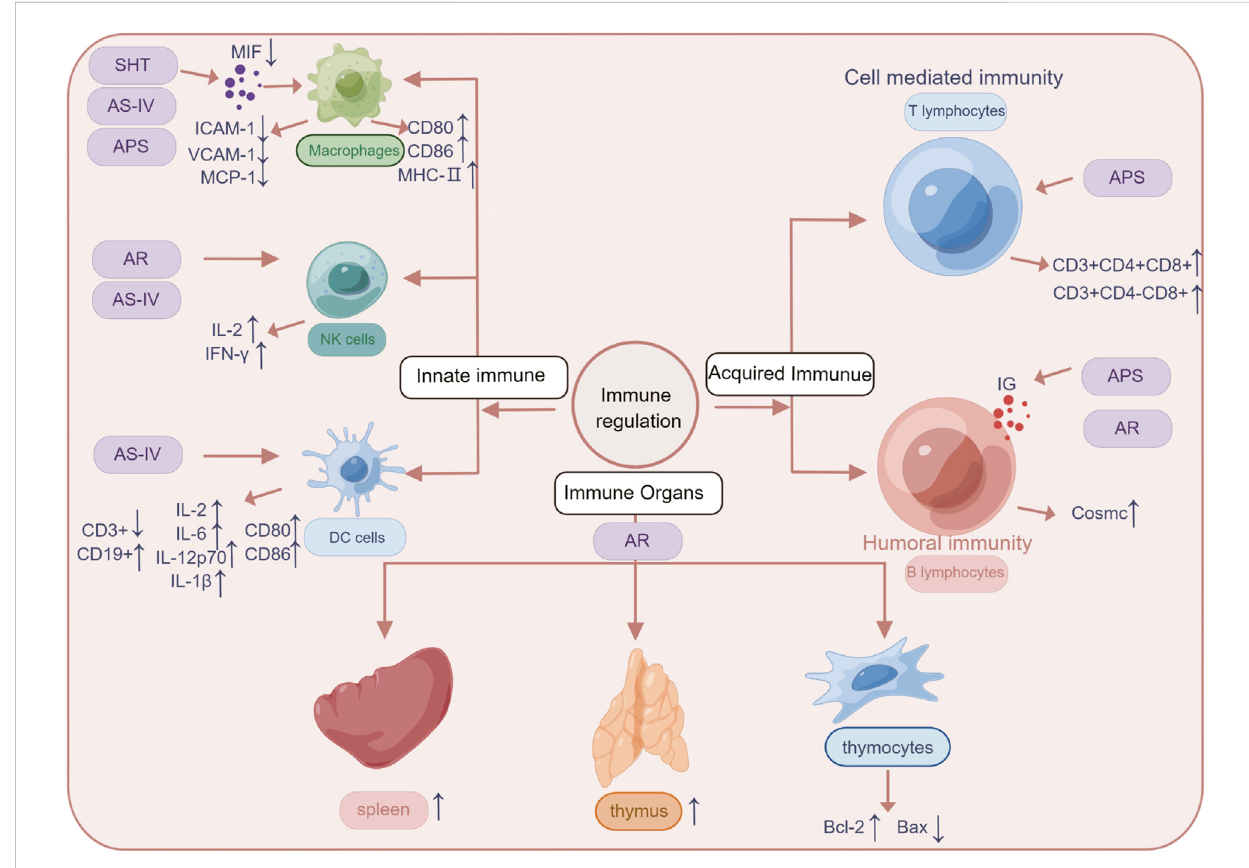
FIGURE 4 The mechanisms linked SHT, AR and AS-IV to the treatment of immune system diseases. Arrows and lines represent signal activation or inhibition. Note: SHT, Fufang Shenhua tablet; AR, Astragali Radix; AS-IV, Astragaloside IV; APS: Astragalus polysaccharide. By Figdraw.